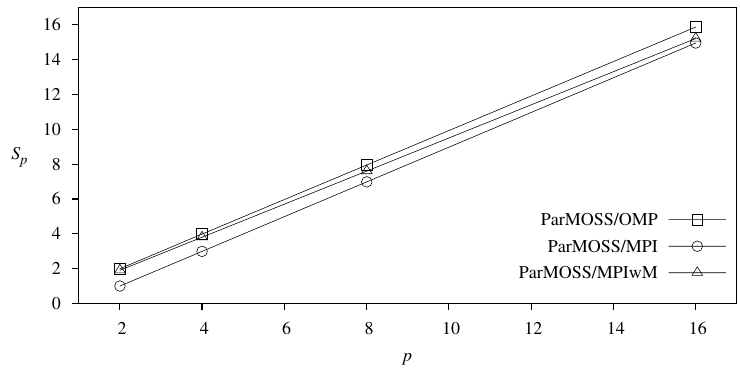
Figure 10. Comparison of speed-up of ParMOSS/MPI with speed-up of ParMOSS/OMP using different numbers of processing